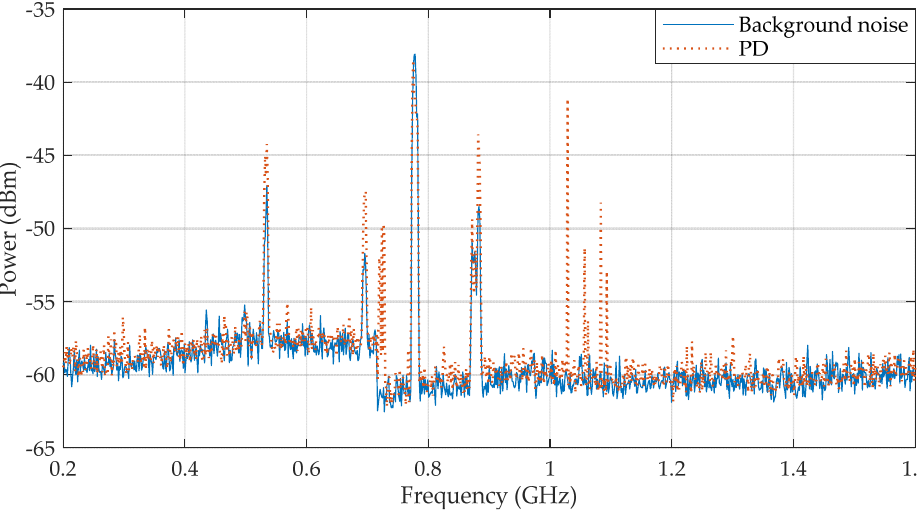
Figure 16. Samples of PD pulses in the frequency domain.